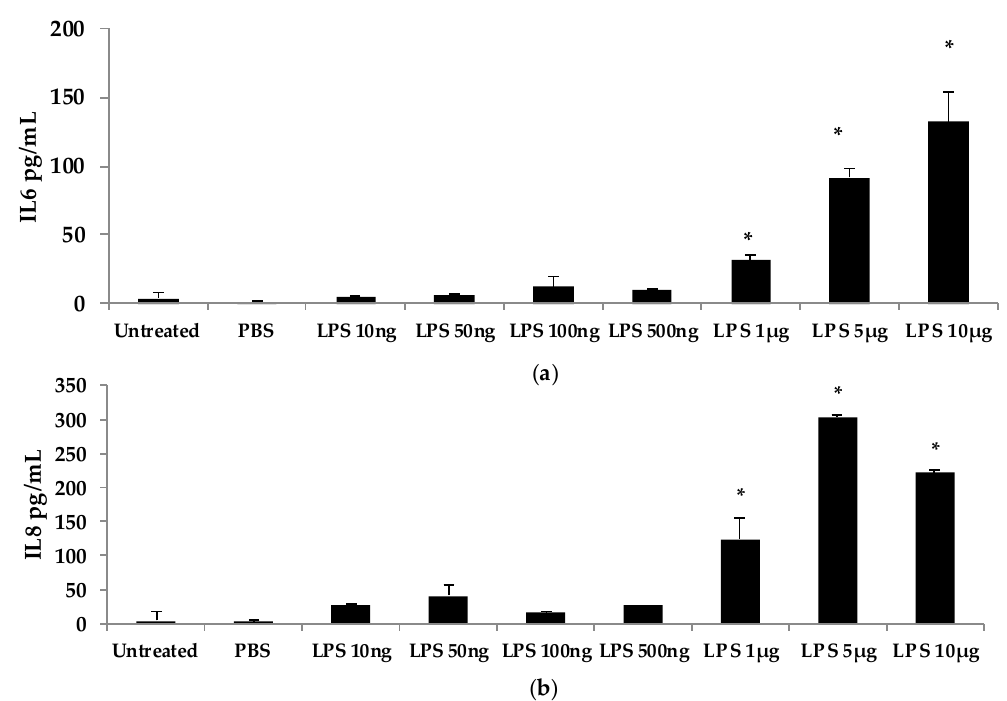
Figure 5. Dose-dependent response of bronchial epithelial BEAS2-B cells to LPS. LPS was added to BEAS-2B cells at a density of 500,000 cells/well for 24 h. ( a ) IL6 measured by enzyme-linked immunosorbent assay (ELISA); ( b ) IL8 measured by ELISA. An * indicates p < 0.05 according to Student’s t -test comparing individual treatments to phospho-buffered saline (PBS) control.